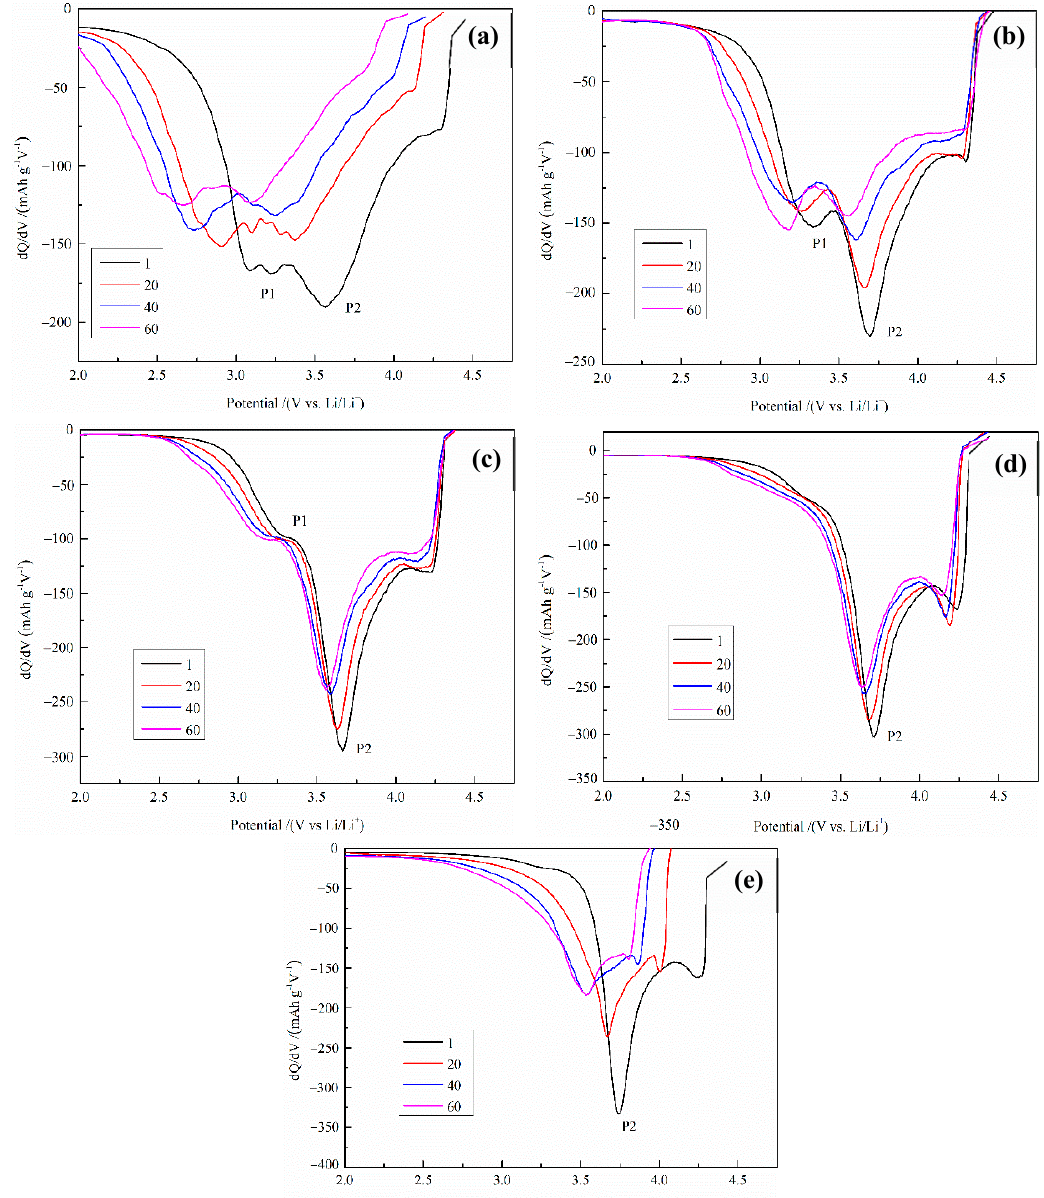
Figure 9. The dQ/dV curves of ( a ) LMNCO, ( b ) nLMNCO-1.0, ( c ) nLMNCO-2.0, ( d ) nLMNCO-3.0, and ( e ) nLMNCO-4.0 cathode